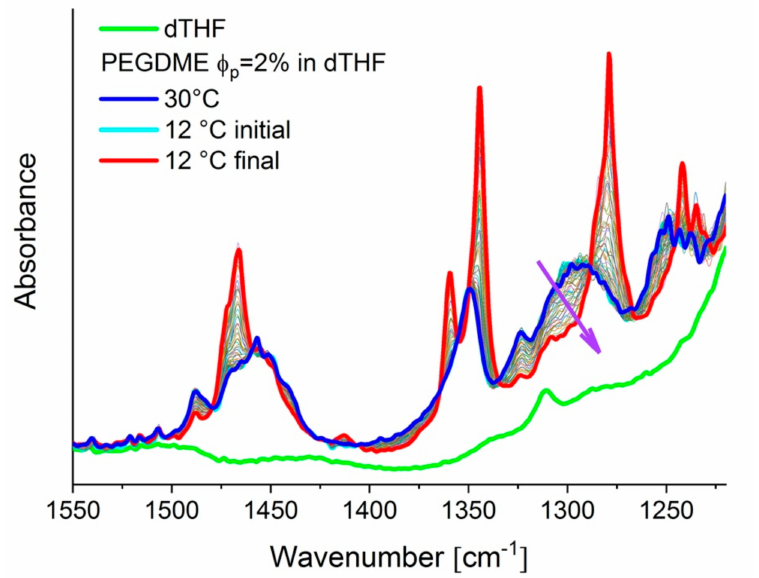
Figure 5. FTIR spectral change observed during the crystallization of hPEGDME (M W = 20,000 g mol − 1 ) from solution in dTHF in decreasing temperature from 30 ◦ C to 12 ◦ C. The arrow indicates the evolution of the FTIR spectra collected between the initial and final states at 12 ◦ C with a time step of 30